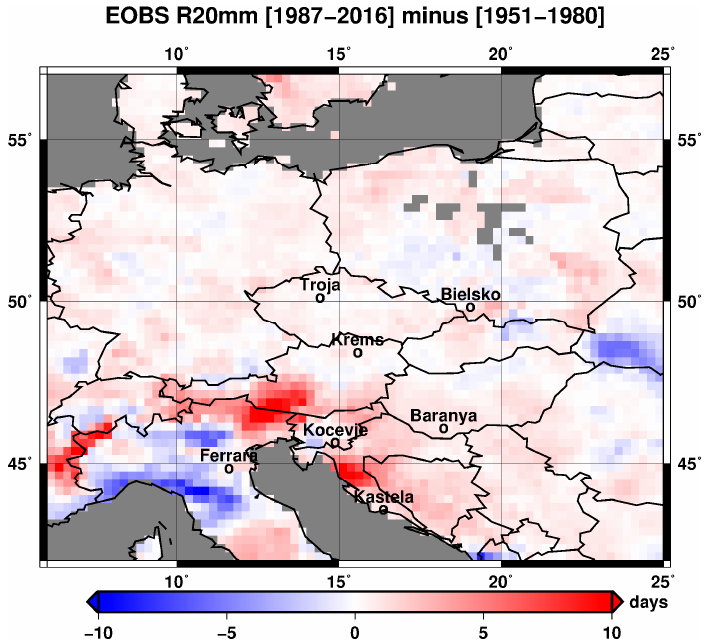
Figure 2. Map related to historical change between the two 30-year periods (1987–2016 and 1951–